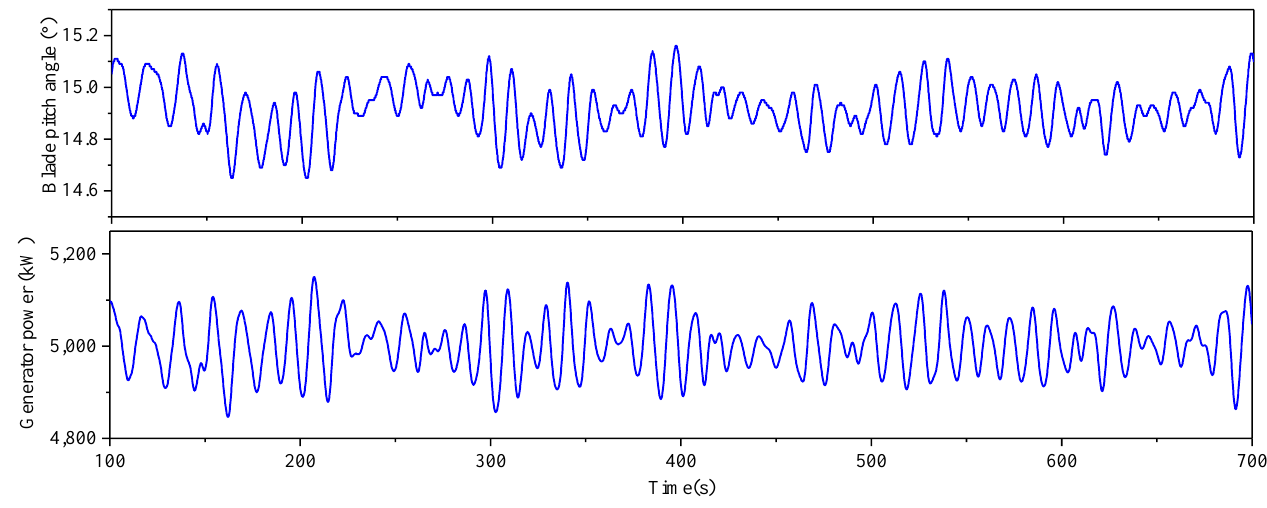
Figure 13. Time histories of pitch angles and power output of the wind turbine under the uniform wind with irregular wave.